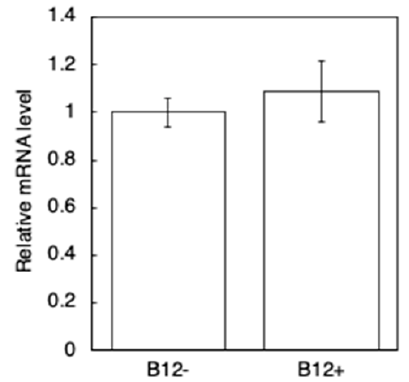
Figure 4. A β mRNA levels in B 12 − , and B 12 + GMC101 worms. The relative expression of A β mRNA was normalized to that of actin-1 . The expression value for B 12 − worms was set to 1. The data represent the mean ± SD of three independent experiments (n = 3).